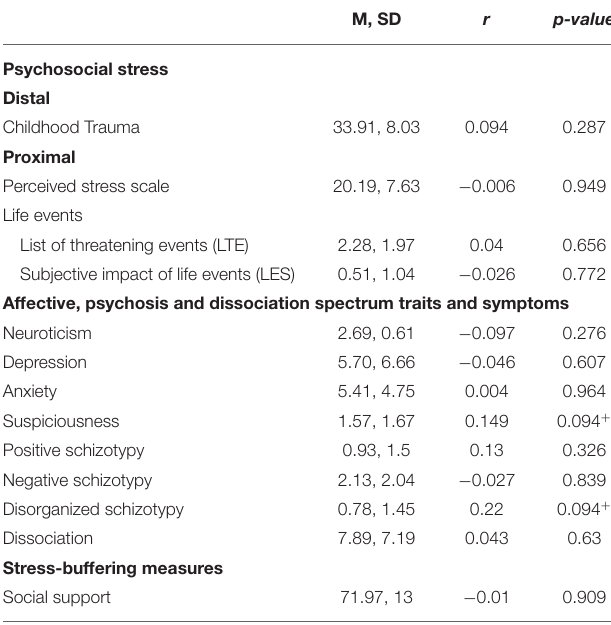
TABLE 2 | Correlational analyses between stress-related and subclinical measures with